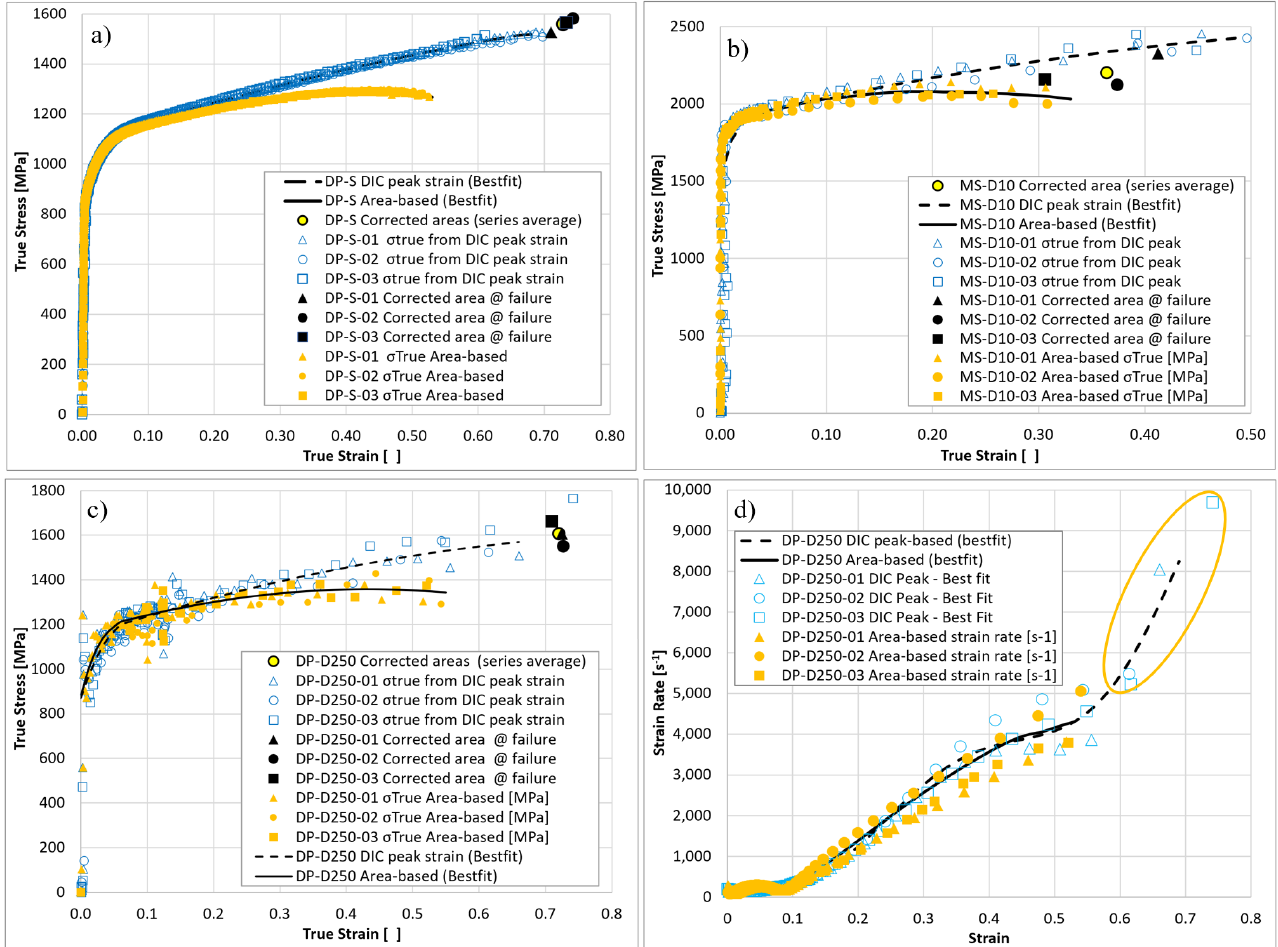
Figure 12. Repeatability of the experiments: DP static true stress-strain curves ( a ); MS dynamic true stress-strain curves at 10 s − 1 ( b ); DP dynamic experiments at 250 s − 1 true stress-strain curves ( c ) and strain rate histories ( d ).